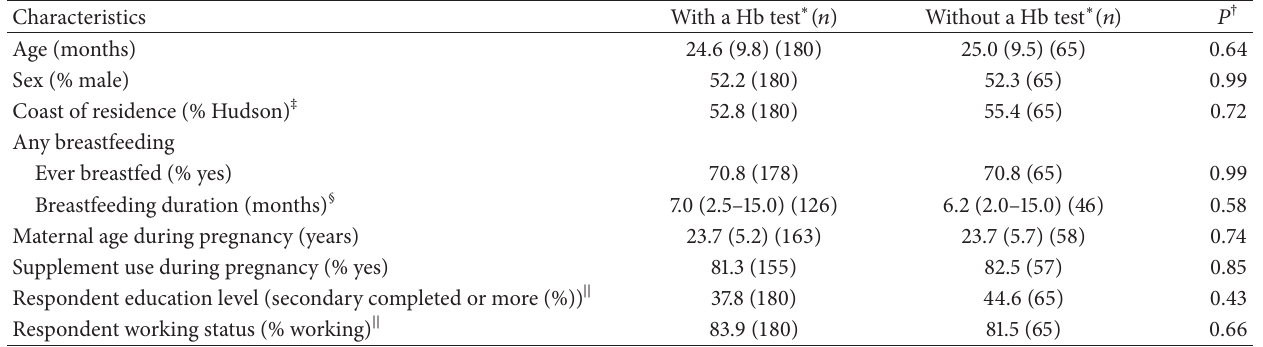
Table 2: Demographic and clinical characteristics of preschool Inuit children with or without a Hb test. Characteristics